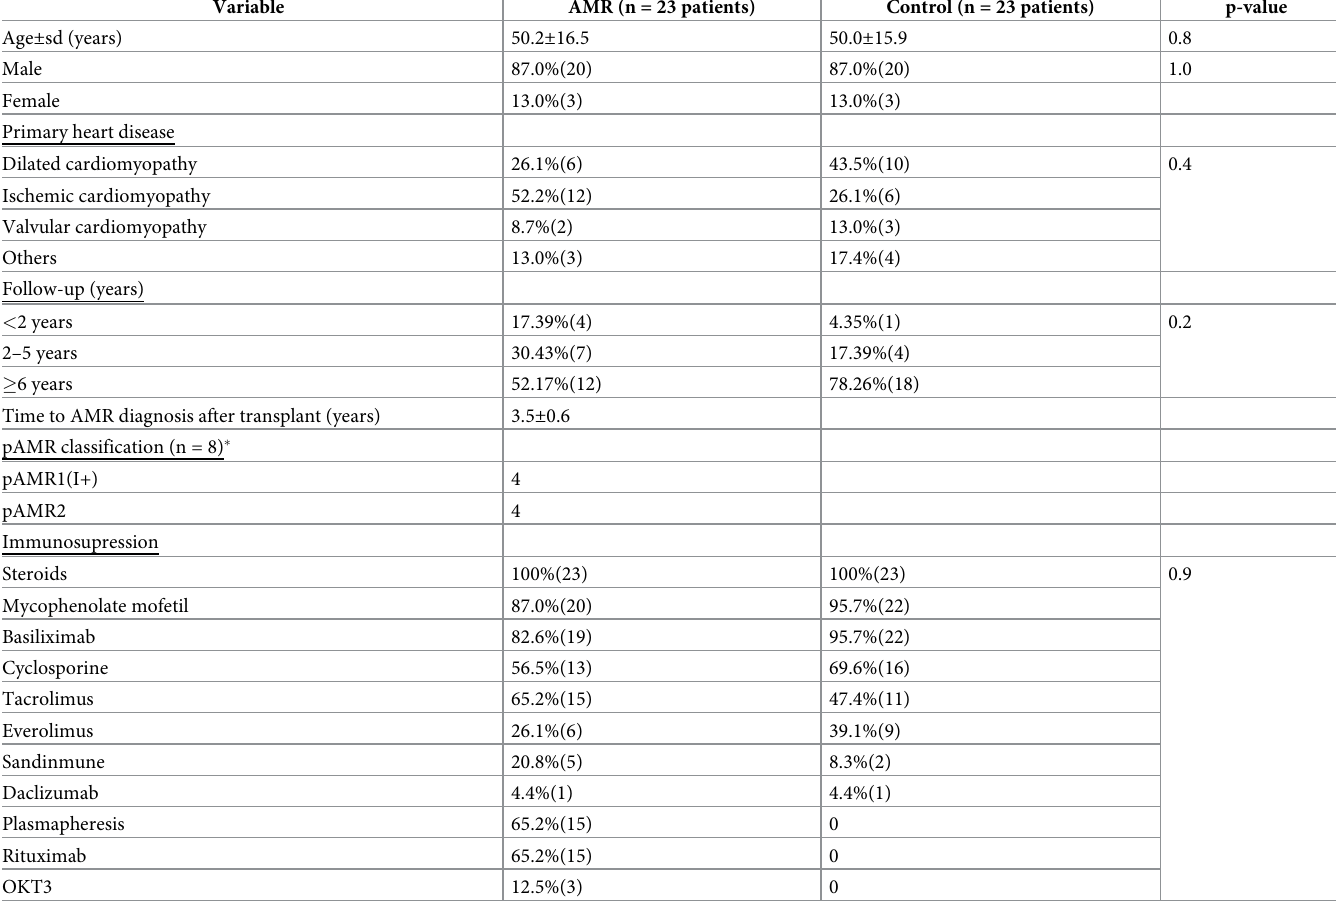
Table 1. Clinical characteristics of the patients included in the